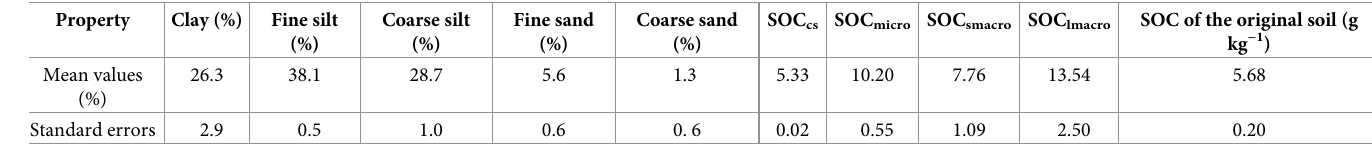
Table 1. Basic characteristics of the original soil used in our